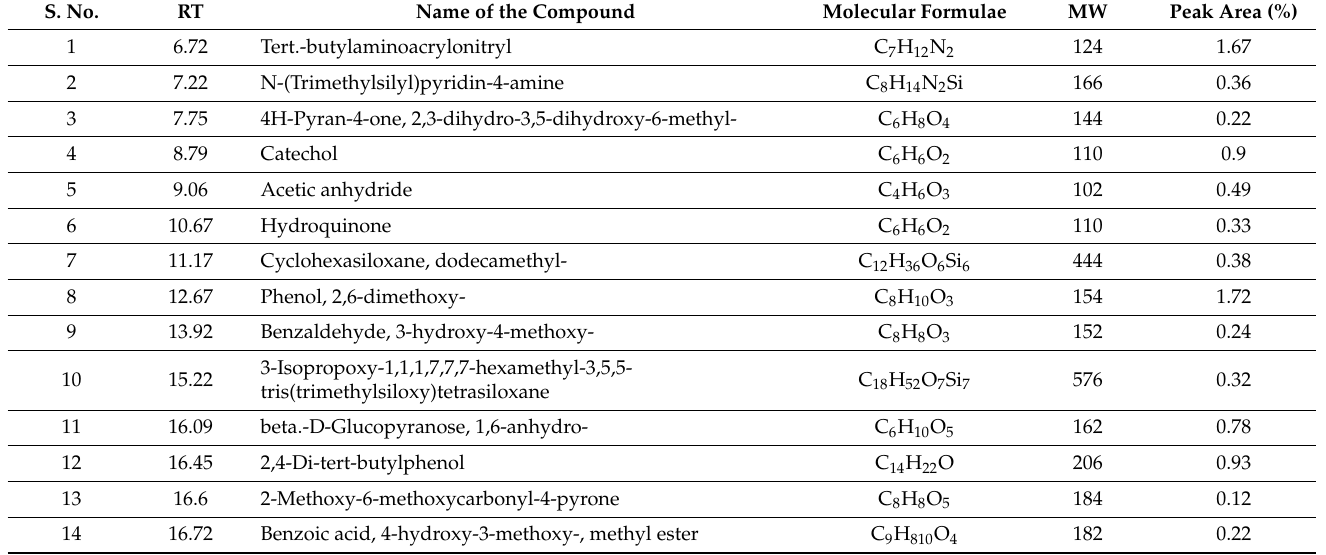
Table 5. Compounds identified in the water-extracted C. fenestratum